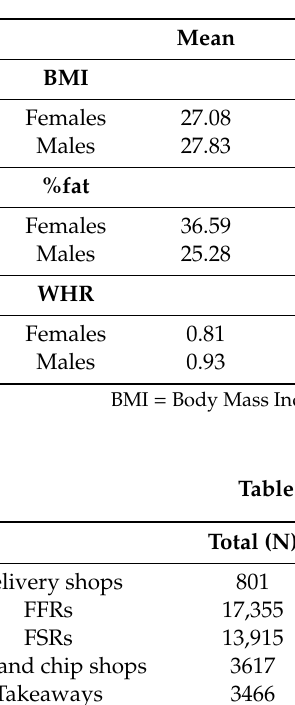
Table 2. Obesity parameters.